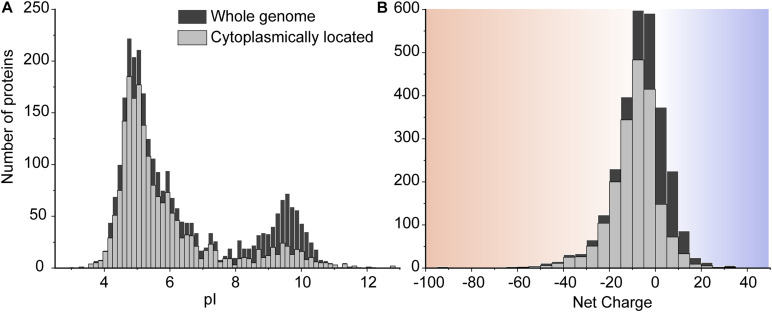
The pI (A) and net charge (B) distributions for proteins of L. monocytogenes EGD-e. The histograms show the number of genes that encode proteins for the whole genome scale and the proteins located in the cytoplasm. We used a pH of 7.5 to calculate the net charge. The cytoplasmic proteins are extracted from the whole proteome based on the secretomics-based subcellular localization database (Renier et al., 2012). To reveal more details in the histogram of the net charge, we removed four super-charged proteins which are outliers in the protein net charge distribution. These are three super-negatively charged cell-wall proteins including a putative peptidoglycan bound protein (with UniProt entry Q8Y697, Z = –241), a peptidoglycan anchored protein (Q8Y479, Z = –140), and Internalin I protein (Q8YA32, Z = –112); and one super-positively charged protein predicted to be on the cell membrane, a putative tape-measure protein of bacteriophage A118 (Q8Y4Z2, Z = 82).